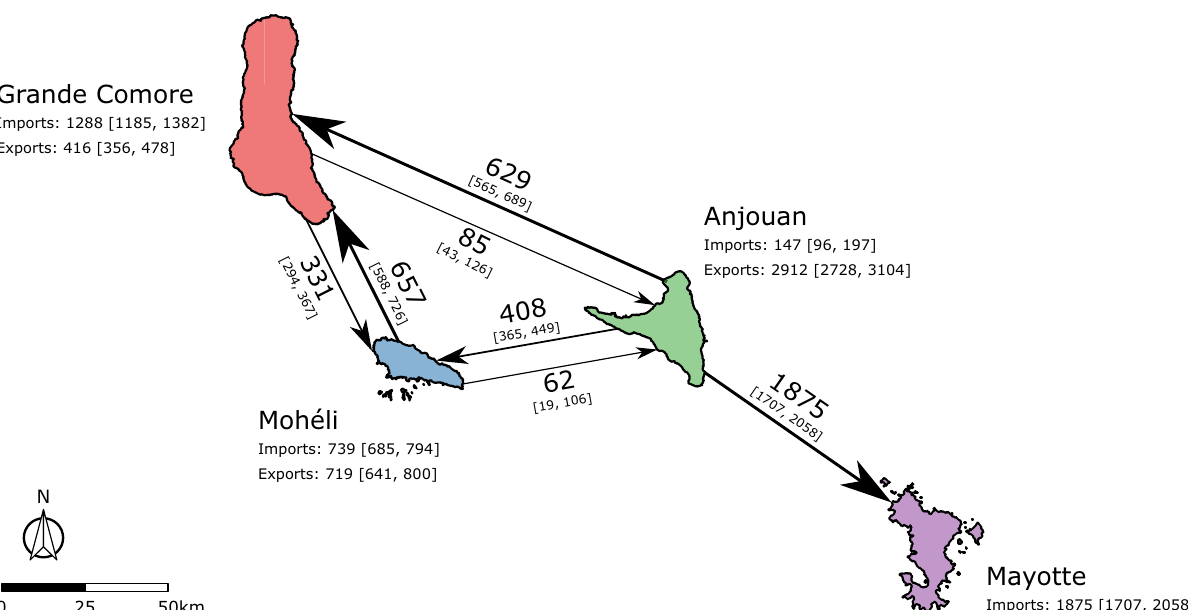
Fig. 3 Estimated livestock trade network in the Comoros archipelago from best fi tted model (Model 3b), presented as the annual number of livestock heads moved between islands. The imports and exports of each island in the Comoros archipelago — Grande Comore (red), Mohéli (blue) and Anjouan (green) and Mayotte (purple) — were estimated by fi tting the metapopulation model to age-strati fi ed sero-surveys conduct from July 2004 until June 2015. The estimated annual trade network of livestock in the Comoros archipelago is shown, with the direction of each arrow indicating the direction of trade between islands. The median and 95% credible interval (CrI) of estimated annual livestock movements are shown on each arrow. Data used to produce the map were made available under Attribution 3.0 Unported (CC BY 3.0) 67 and Creative Commons Attribution for Intergovernmental Organisations (CC BY- IGO) 68 licenses. The former (CC BY 3.0) licenced the data for Mayotte 69 , and the latter (CC BY-IGO) licenced the data for the Union of Comoros 70 . All presented data was